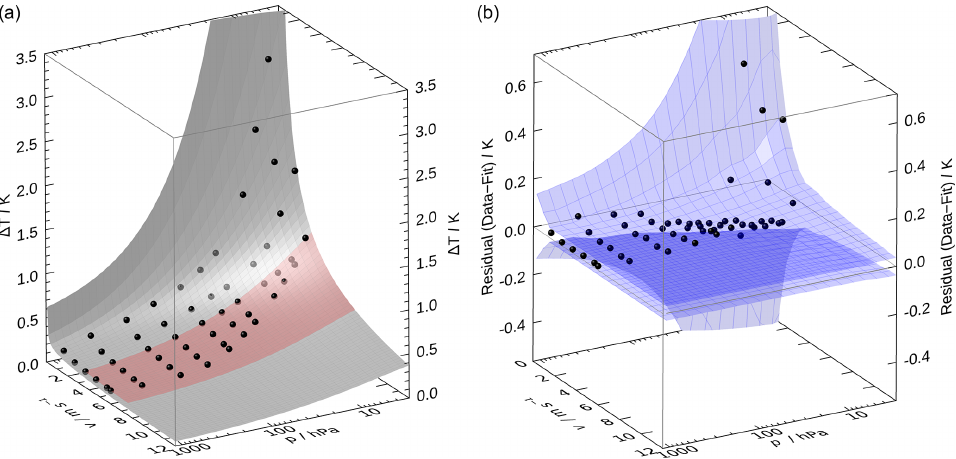
Figure 13. (a) Representation of the measured data (black dots) and the fitted model according to Eq. (5) for the same data set as in Fig. 12. The red coloured part of the surface denotes the typical v range in radiosonde ascents. (b) Overall uncertainty in a similar representation, showing the deviations of the measured points from the model as black dots, and 1 σ -uncertainty estimates as blue shaded surfaces. The plots are intended to give an overview over the magnitude and the distribution of the data points over the p – v space.